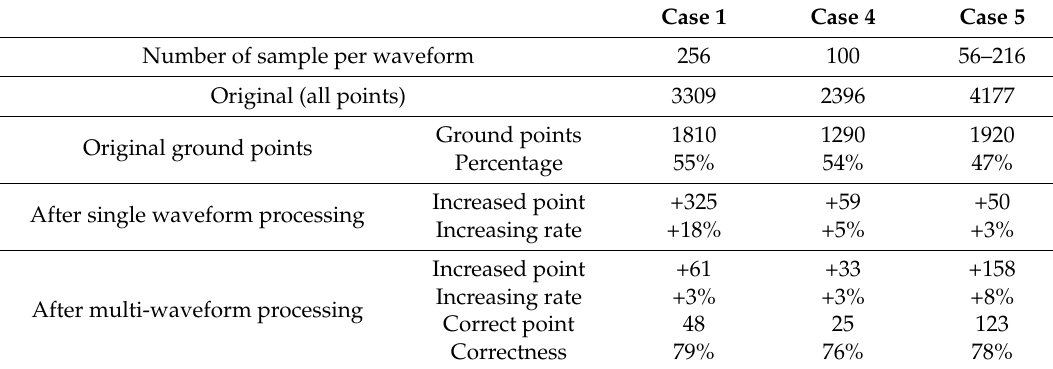
Table 5. The comparison between different sampling numbers.